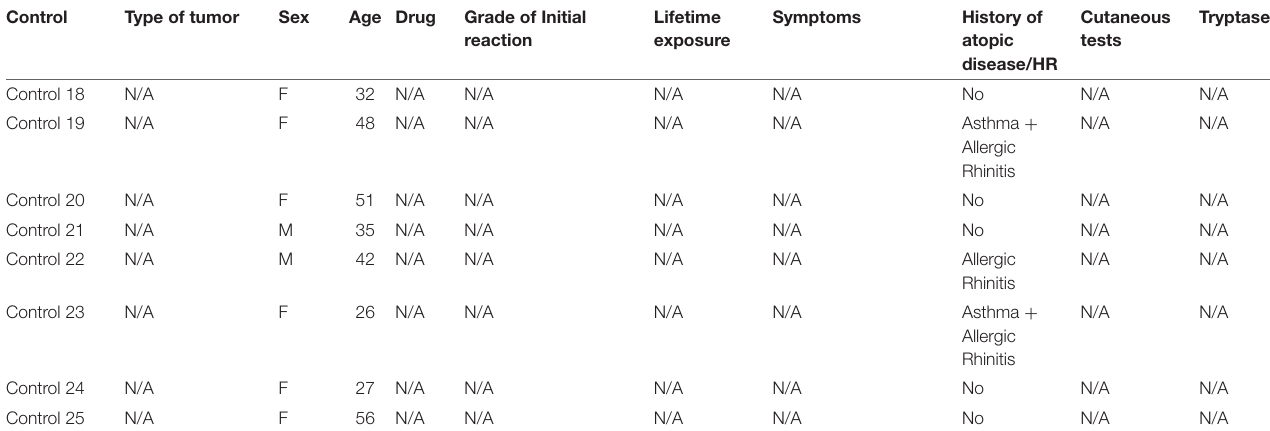
TABLE 2 | General characteristics of healthy control group. Control Type of tumor Sex Age Drug Grade of Initial